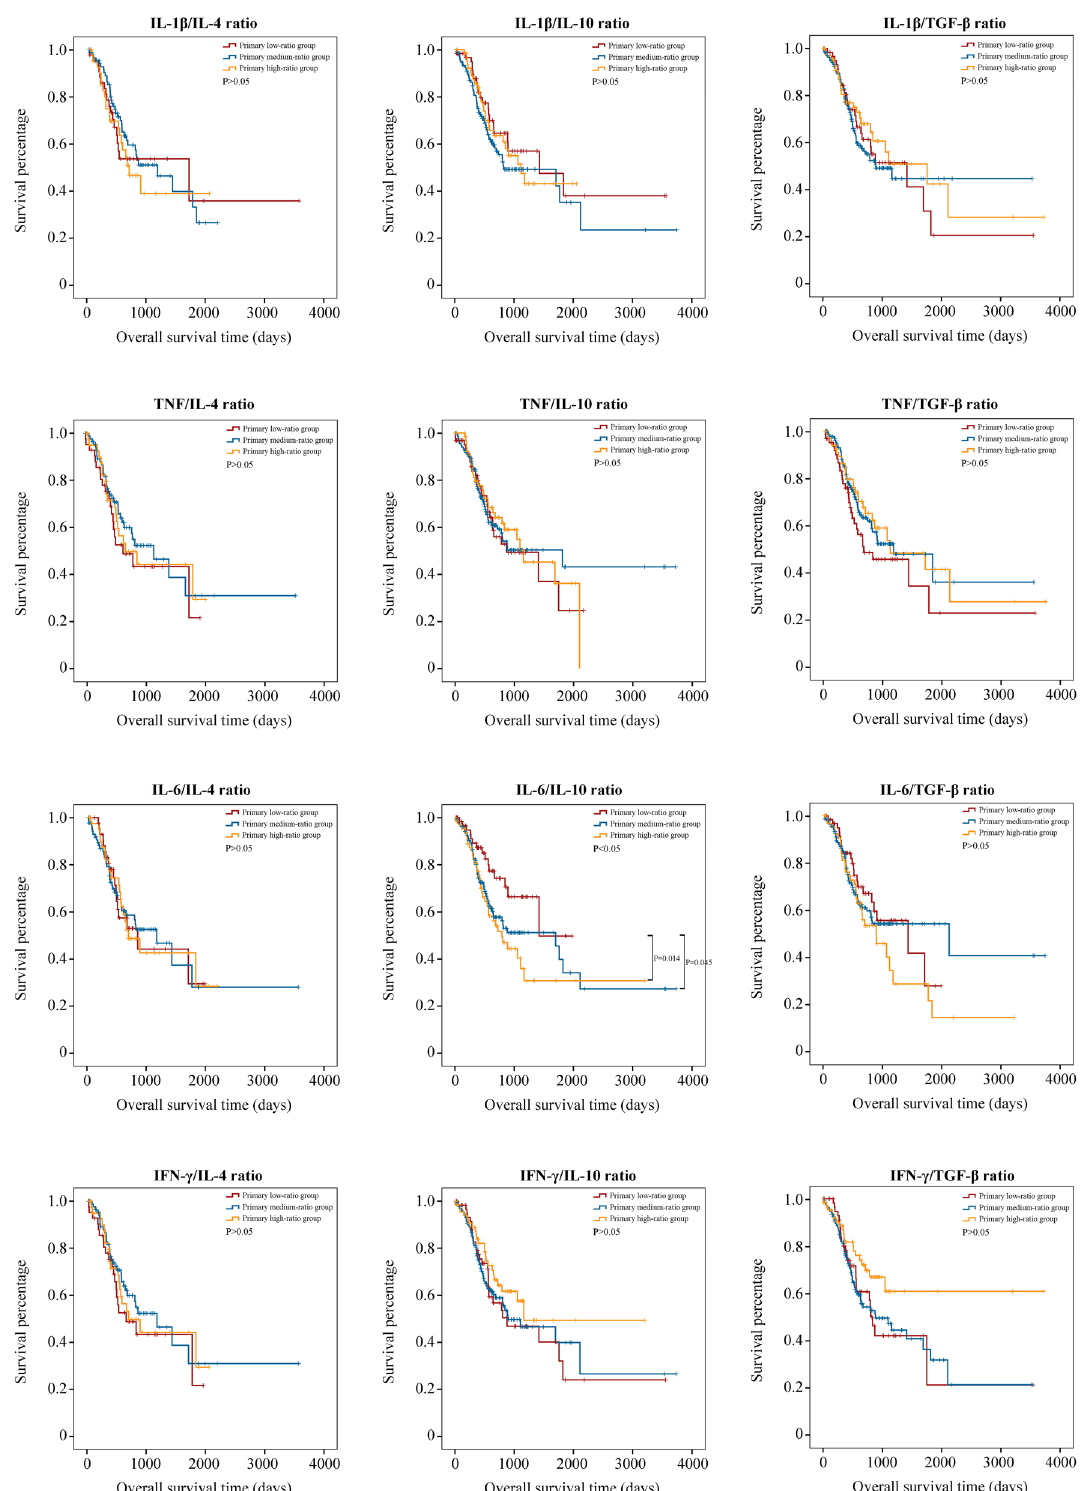
Figure 2. The prognostic values of common pro-inflammatory-to-anti-inflammatory factor mRNA expression